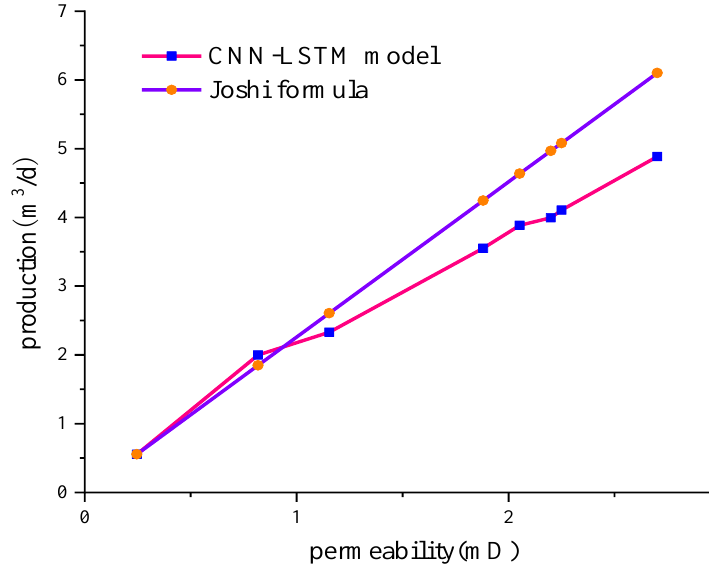
Figure 13. Effect of permeability on production.